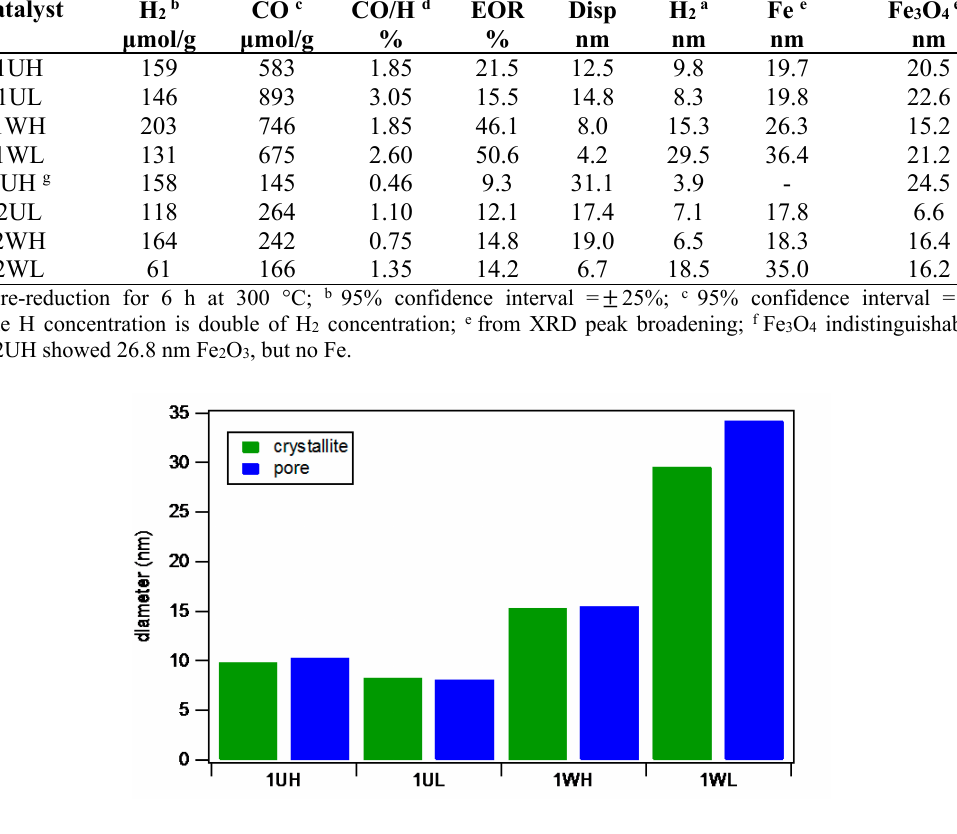
Figure 4. Comparison of average pore diameters from BET with average Fe crystallite diameters calculated from H 2 uptake for 1S